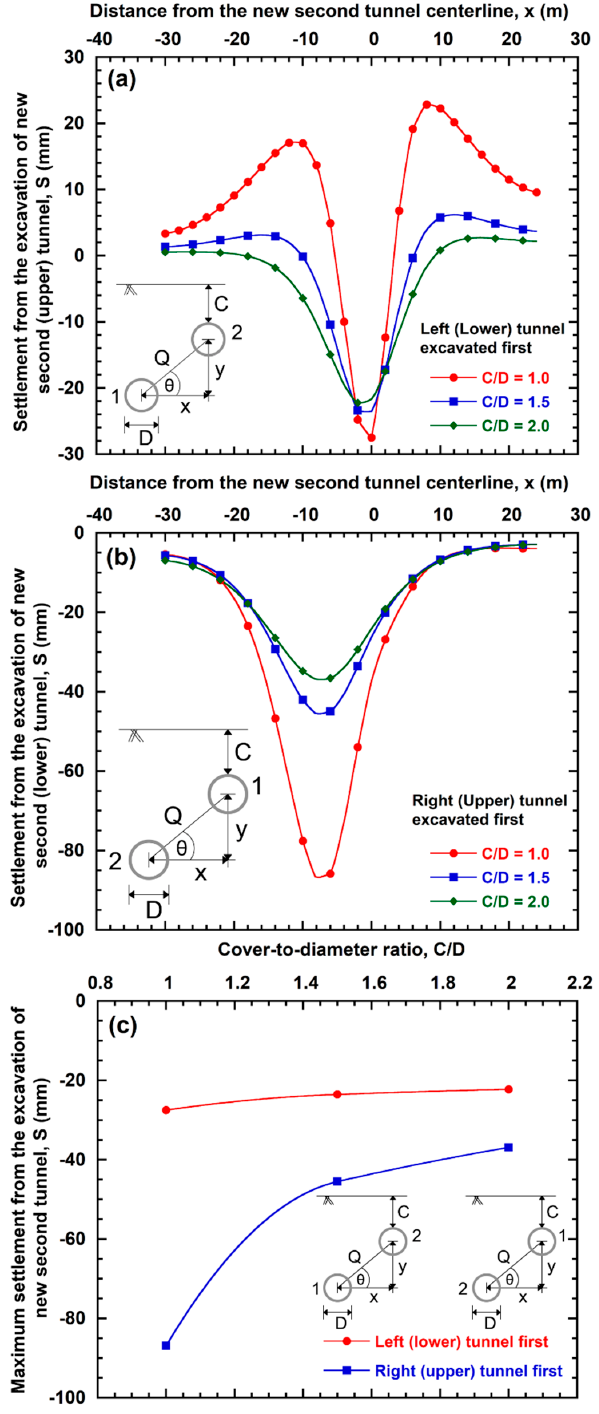
Figure 15. Effect of cover-to-diameter ratio on ( a , b ) surface settlement above the new second tunnel and ( c ) maximum settlement from the excavation of the new second tunnel.